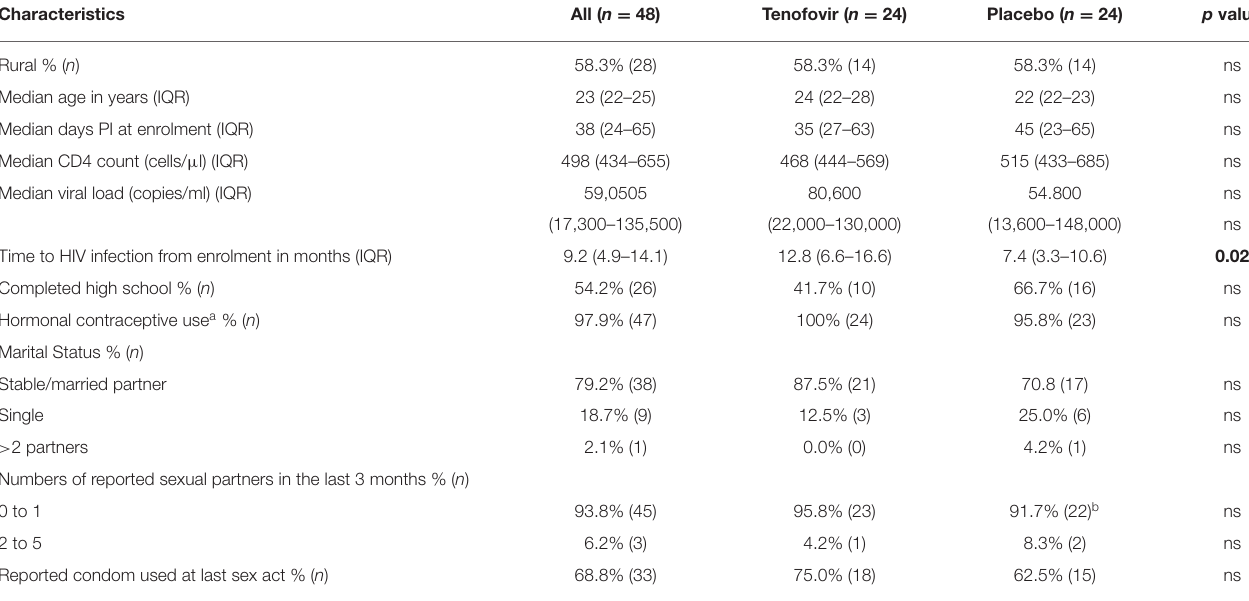
TABLE 1 | Demographics and clinical characteristics of the sub-set of women who acquire HIV infections during the CAPRISA 004 trials ( n = 48). Characteristics